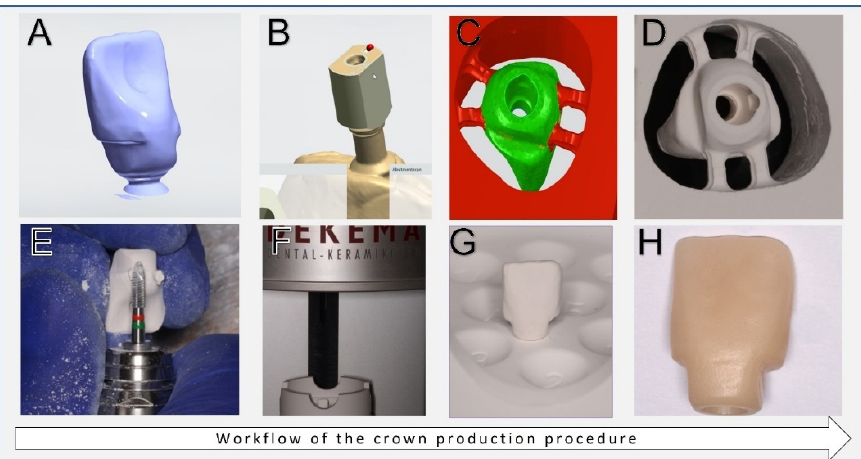
Figure 3. CAD/CAM crown design and production. ( A ) The scanned prototype. ( B ) The scanned scan body. ( C , D ) Access canal for the retention screw. ( E ) Crown finishing. ( F , G ) Sintering the crowns. ( H ) The final crown.